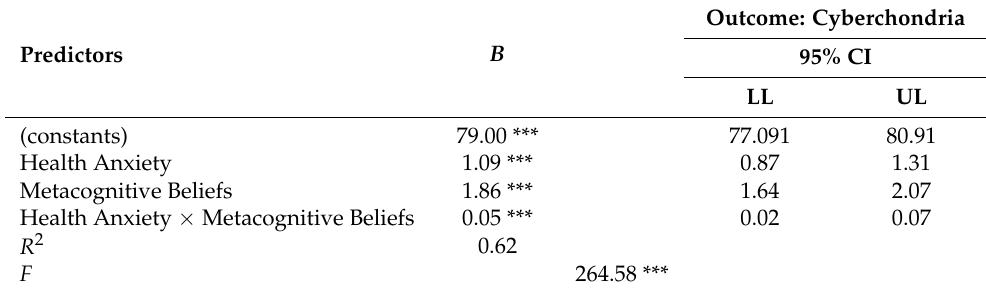
Table 4. Moderation of metacognitive beliefs between health anxiety and cyberchondria ( N = 500).